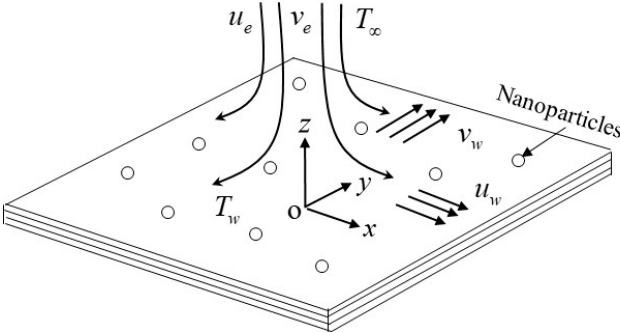
Figure 1. Flow model and coordinate systems of the physical model.